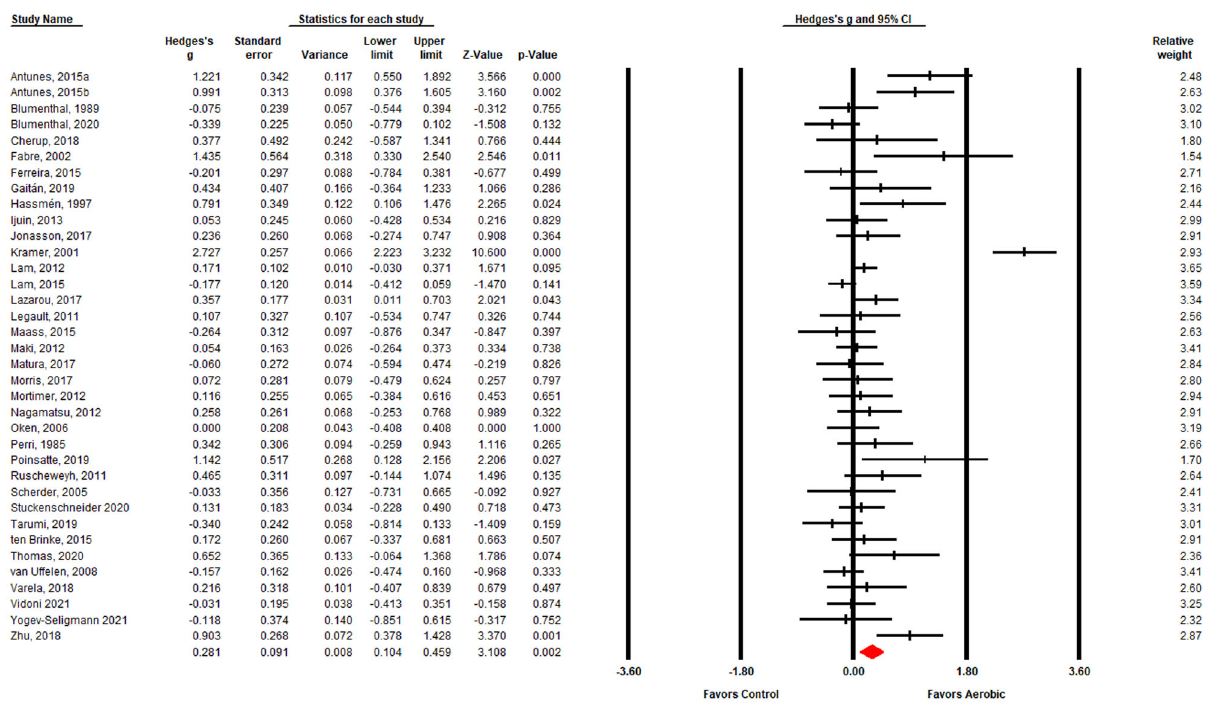
Fig. 2 Forest plot of individual studies ( n = 36) and pooled effects of aerobic exercise interventions on episodic memory. Hedges ’ g , denoted as a diamond or a square, re fl ect improvements in episodic memory among those in the aerobic exercise group relative to the control group when the value is positive. A random-effects model was used. Error bars stand for 95% CI.